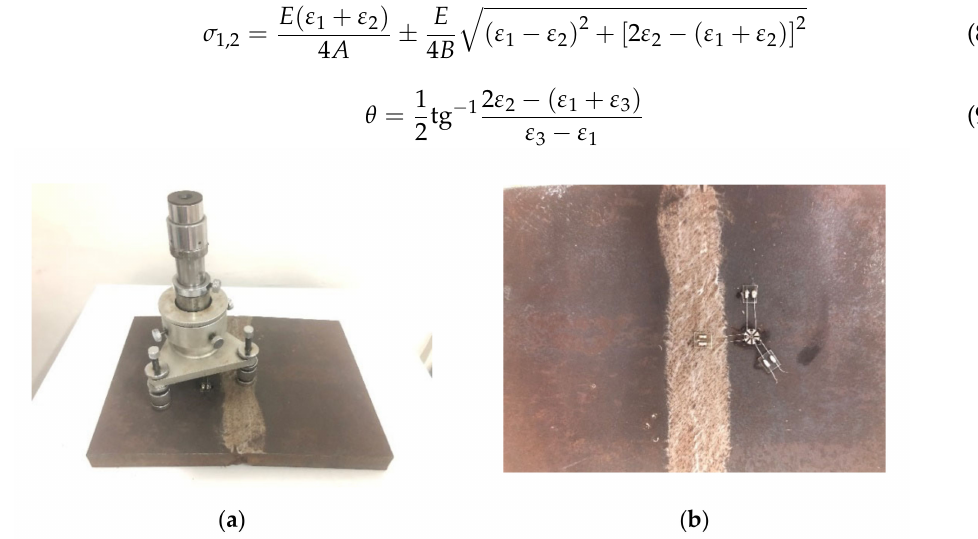
Figure 12. Experimental equipment:( a ) alignment device and ( b ) TJ-120-1.5- ϕ 1.5 strain rosette.